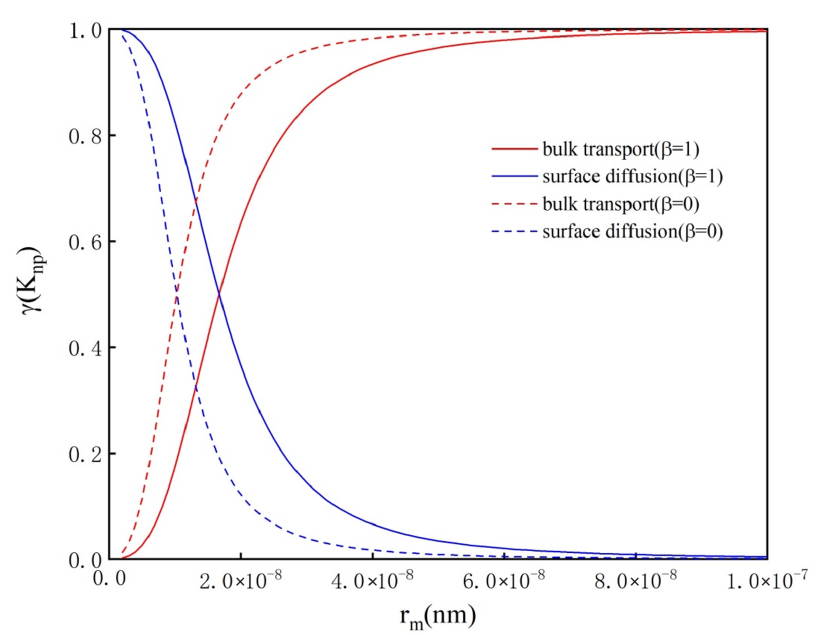
Figure 5. Under different degrees of water molecular coverage, considering K n mechanism vs. pore radius (P = 1 MPa).